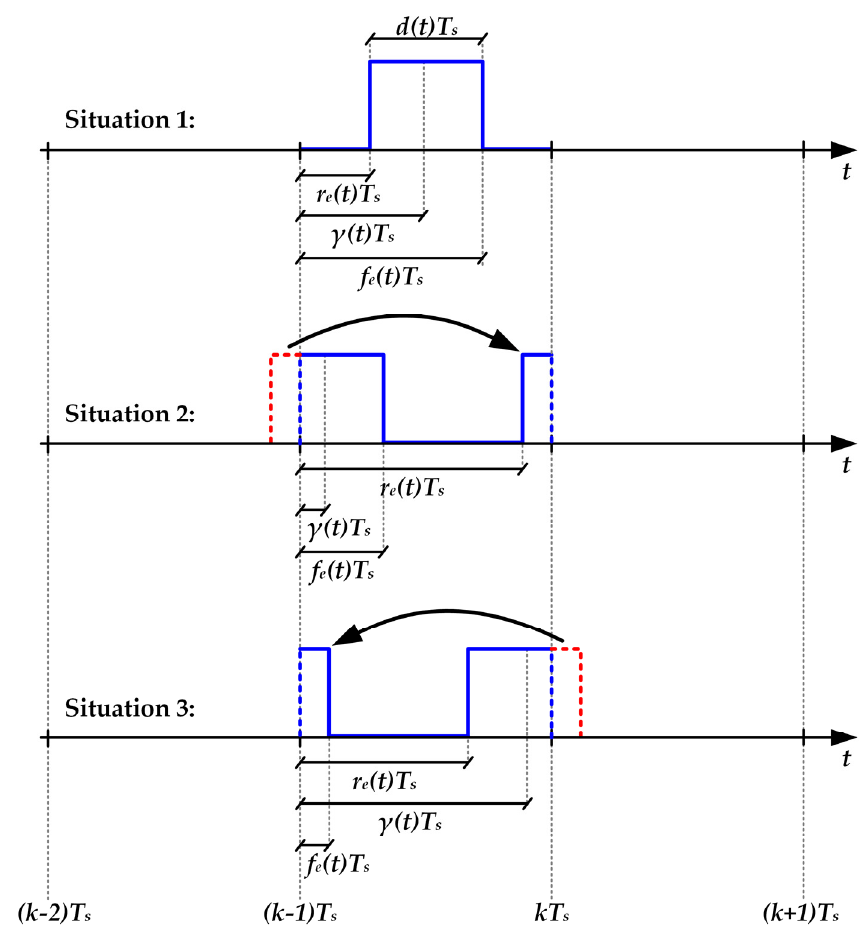
Figure 12. Situations to be considered for generating the voltage pulses of v control (t) .